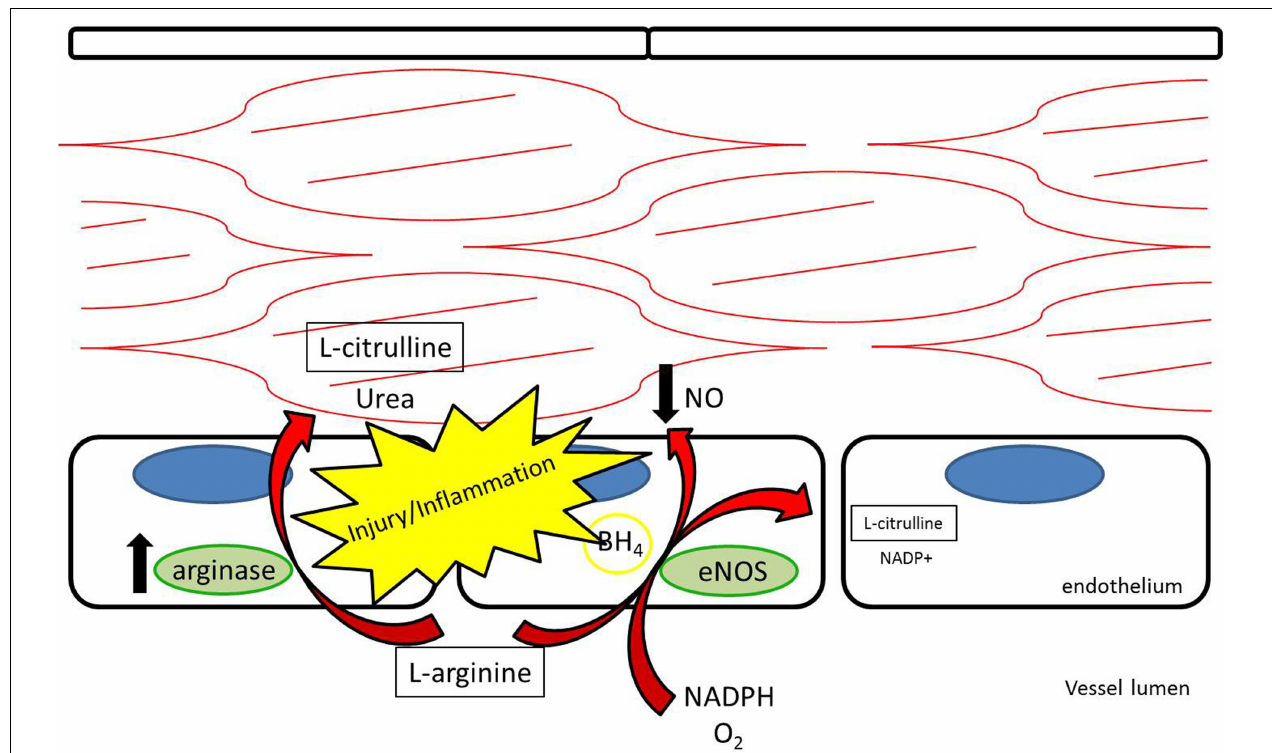
FIGURE 2 | L-arginine may be competitively metabolized by arginase to L-citrulline and urea, reducing production of nitric oxide and contributing to vascular dysfunction